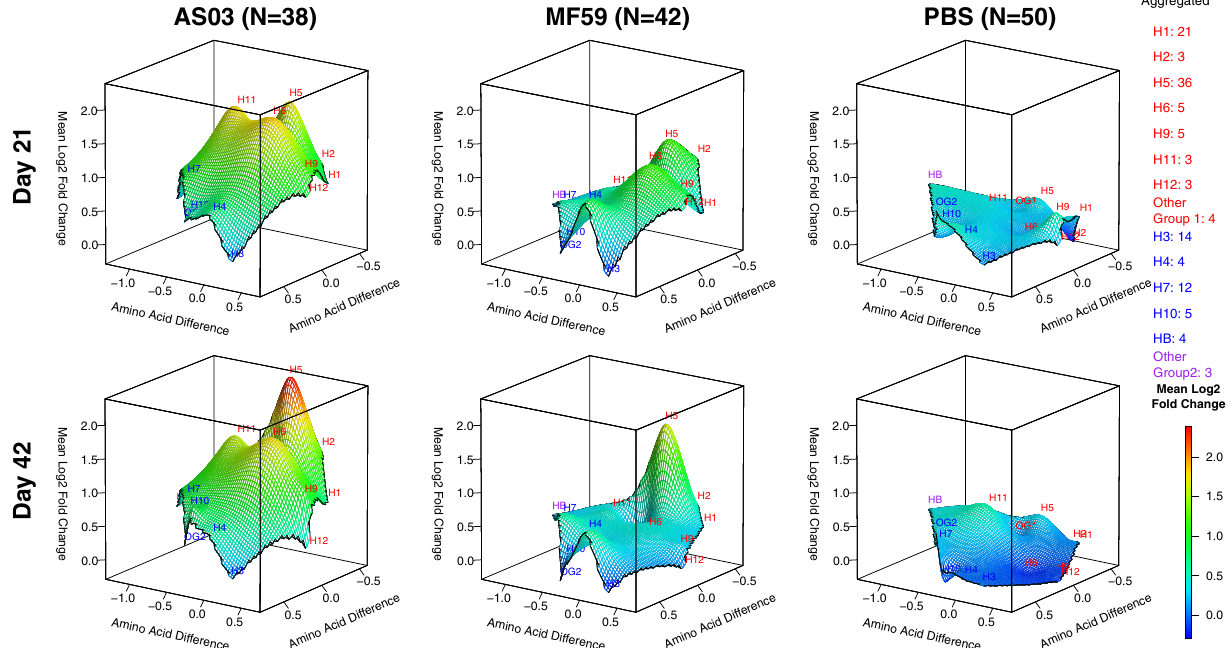
Fig. 6 Adjuvants boosted IgA antibodies against head H5 HA proteins post second dose. IgA antibody landscapes for HA1 subunit antigens based on mean log 2 fold change relative to pre-vaccination adjusted for seasonal in fl uenza vaccination (Experiment 1). In red: Group 1 HA1 antigens, in blue: Group 2 HA1 antigens, in purple: in fl uenza B HA1. The y and x axes project antigen protein sequence divergence as measured in the number of amino acid differences between antigen protein using multidimensional scaling. For each antigen, fi rst the mean log 2 fold change in antibody fl uorescent intensity relative to pre-vaccination adjusted for prior seasonal in fl uenza vaccination was determined (LSMEAN). For subtypes with multiple antigens, the mean LSMEAN and MDS dimensions were used to present the results in the 3D